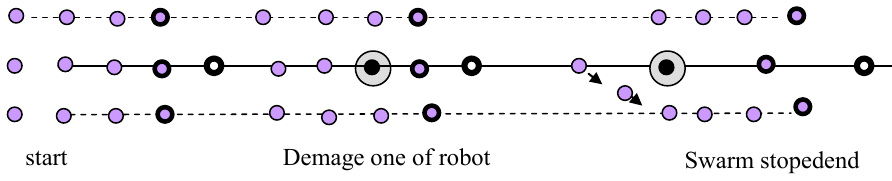
Figure 16. The column change for followers of a failed robot.